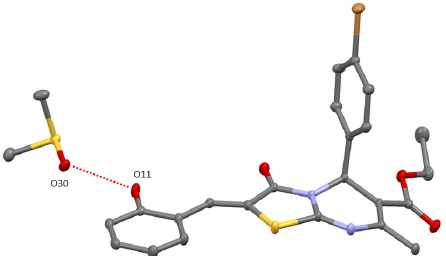
Figure 5. ORTEP-view of solvate complex 12-DMSO . The ellipsoids are presented with 50% proba- Figure 5. ORTEP ‐ view of solvate complex 12 ‐ DMSO . The ellipsoids are presented with 50% prob ‐ bility, H-atoms are omitted for clarity. H-bonding is presented by red dotted ability, H ‐ atoms are omitted for clarity. H ‐ bonding is presented by red dotted lines.